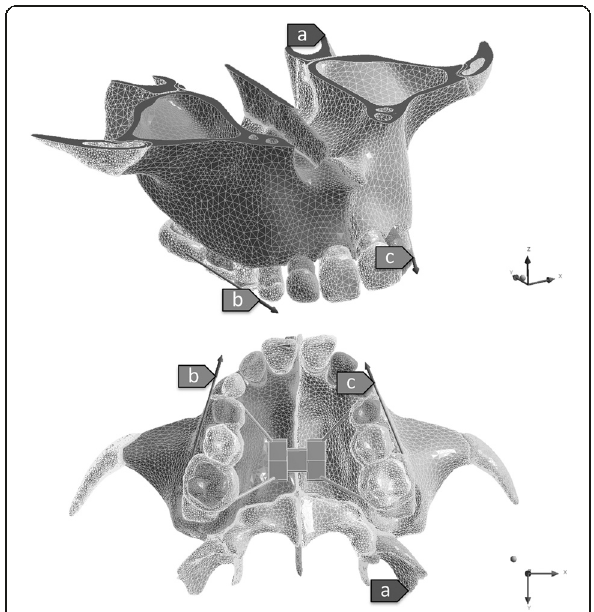
Fig. 1 Model geometry. a Fixed support. b , c Protraction force